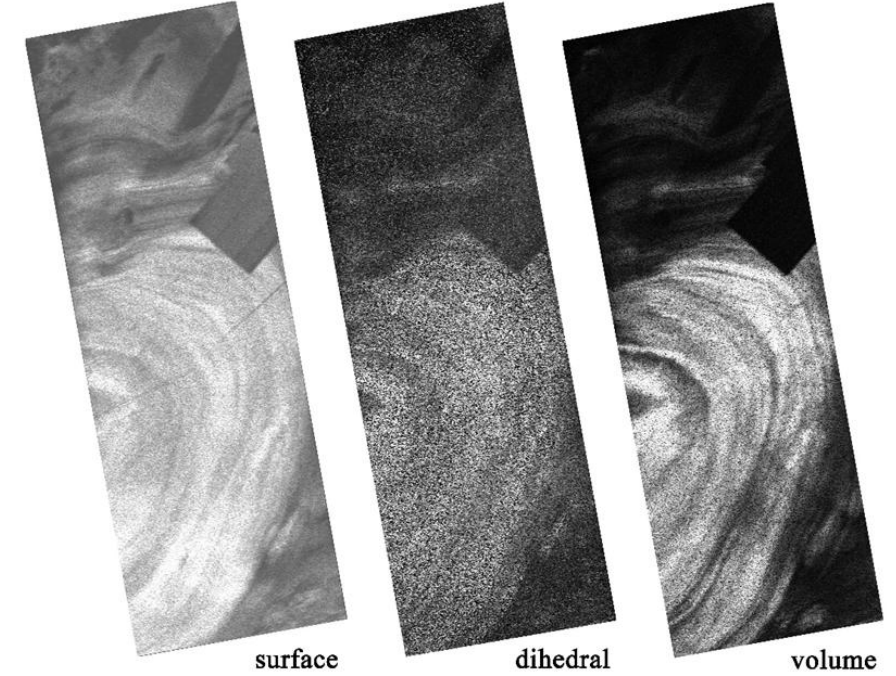
Figure 9. Polarimetric decomposition results in surface scattering, dihedral scattering and volume scattering with model-based decomposition (Yamaguchi four-component decomposition), based on ALOS-PALSAR data (25.6° incidence angle, 6 May 2009). The coverage of this scene image is shown in Figure 1 as a dashed